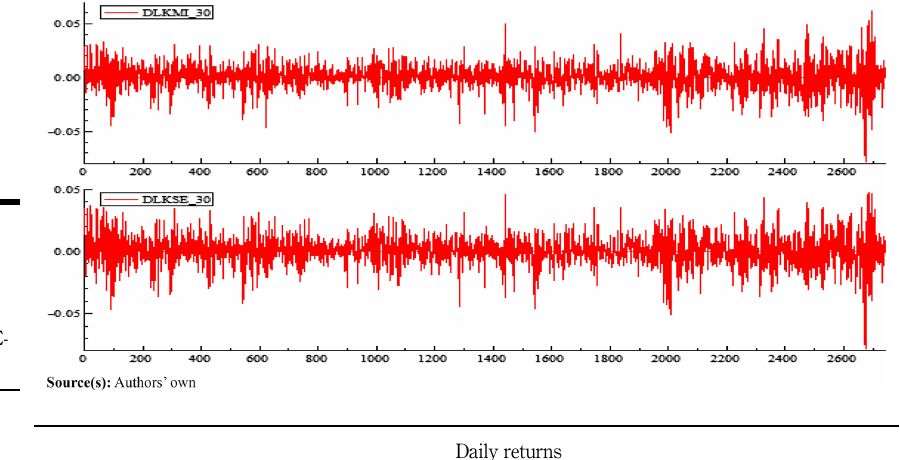
Figure 2. Daily returns of KSE- 30 and KMI-30